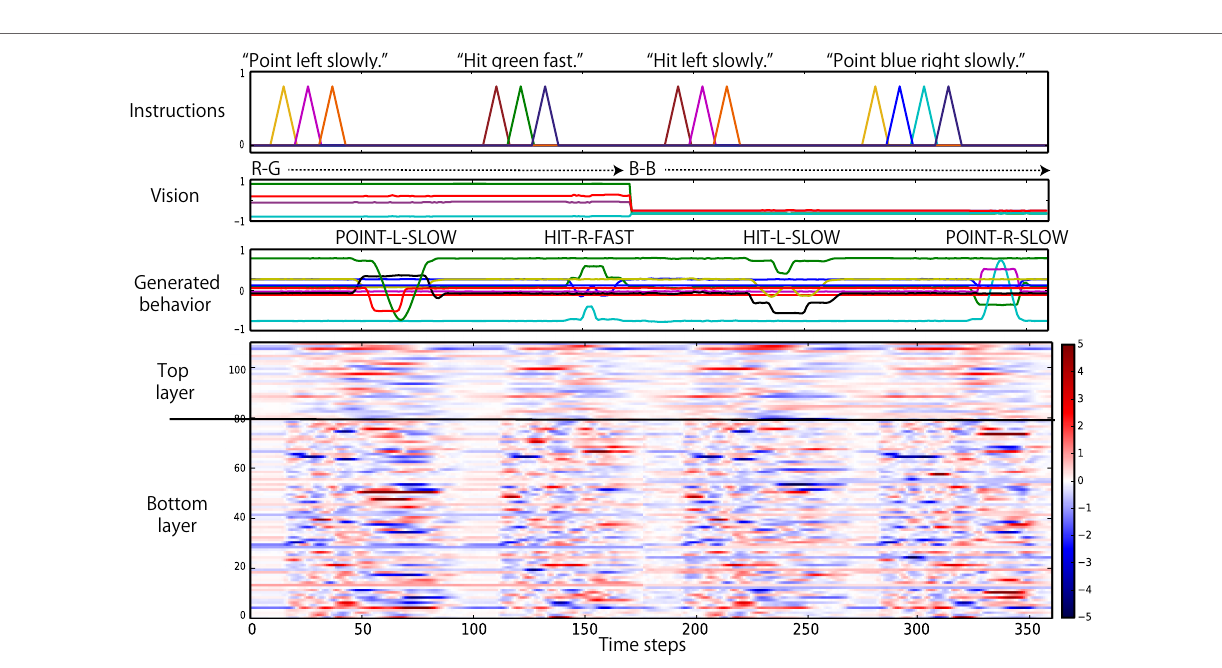
FIGURE 7 | Comparison of the internal dynamics of the bottom and top layers during evaluation . The y -axis of the color map is the index of the neural units. When the internal state of a unit at a particular time step is more (less) than + 5.0 ( (cid:0) 5.0), the edge color is provided. The internal states of the bottom layer change more quickly, in general, than the internal states of the top